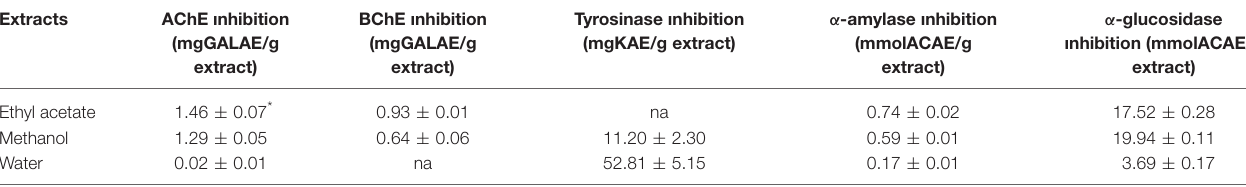
TABLE 6 | Enzyme inhibitory effects of the extracts.